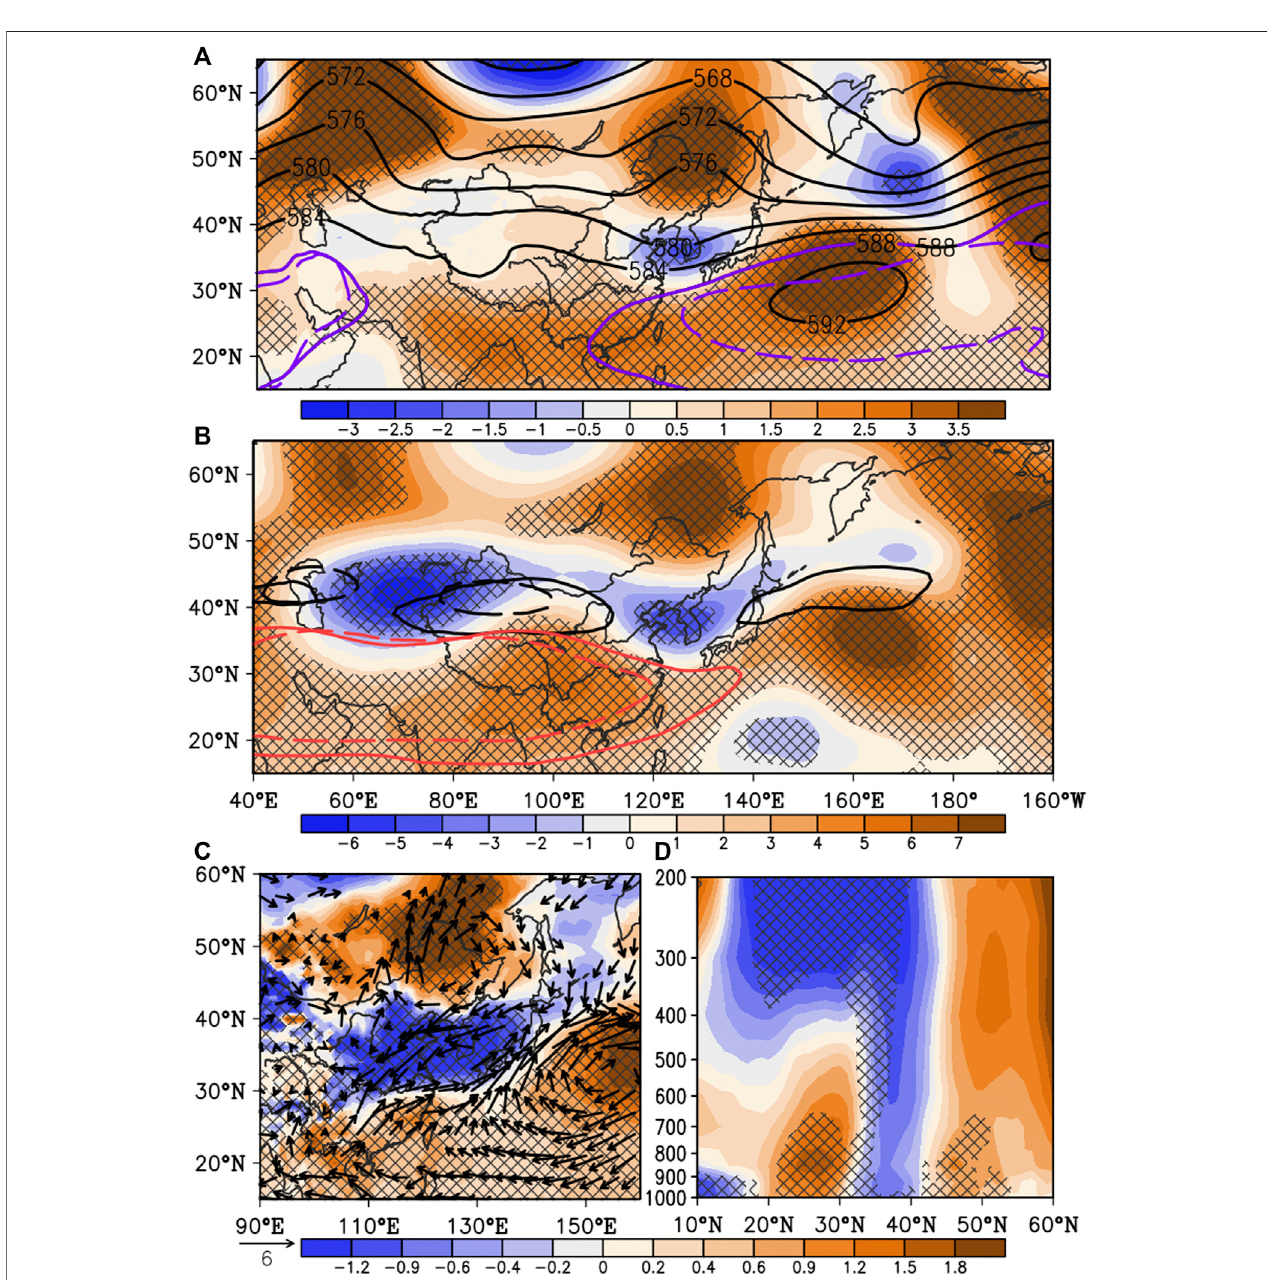
FIGURE 4 | As in Figure 3 but for composite analysis from July 1 to July 31, 2020. (A) Composites of original values (contours, unit: dagpm) and anomalies (shaded, unit: dagpm) of 500-hPa geopotential heights averaged from June 1 to June 30, 2020. Purple solid and dashed lines are 2020 and climatological 588-dagpm contour of 500-hPa geopotential heights, respectively. (B) Composite anomalies of 200-hPa geopotential heights (shaded, unit: dagpm) averaged from June 1 to June 30, 2020. Black solid and dash lines are 2020 and climatological 30 m s -1 contour of 200-hPa zonal winds, respectively. Red solid and dash lines are 2020 and climatological 1,252-dagpm contour of 200-hPa geopotential heights, respectively. (C) Composite anomalies of 925-hPa air temperature (shaded, unit: ° C) and winds (unit:m s -1 ).Onlyanomalywindsvalueexceeding0.05signi fi cancelevelisshownbyvectors. (D) Verticalsectionofcompositeanomaliesofmeridionalwinds(unit:m s -1 ) averaged over East Asia along 105 o E – 135 o E. Crossed area in each panel denotes anomalies exceeding 0.05 signi fi cance level.